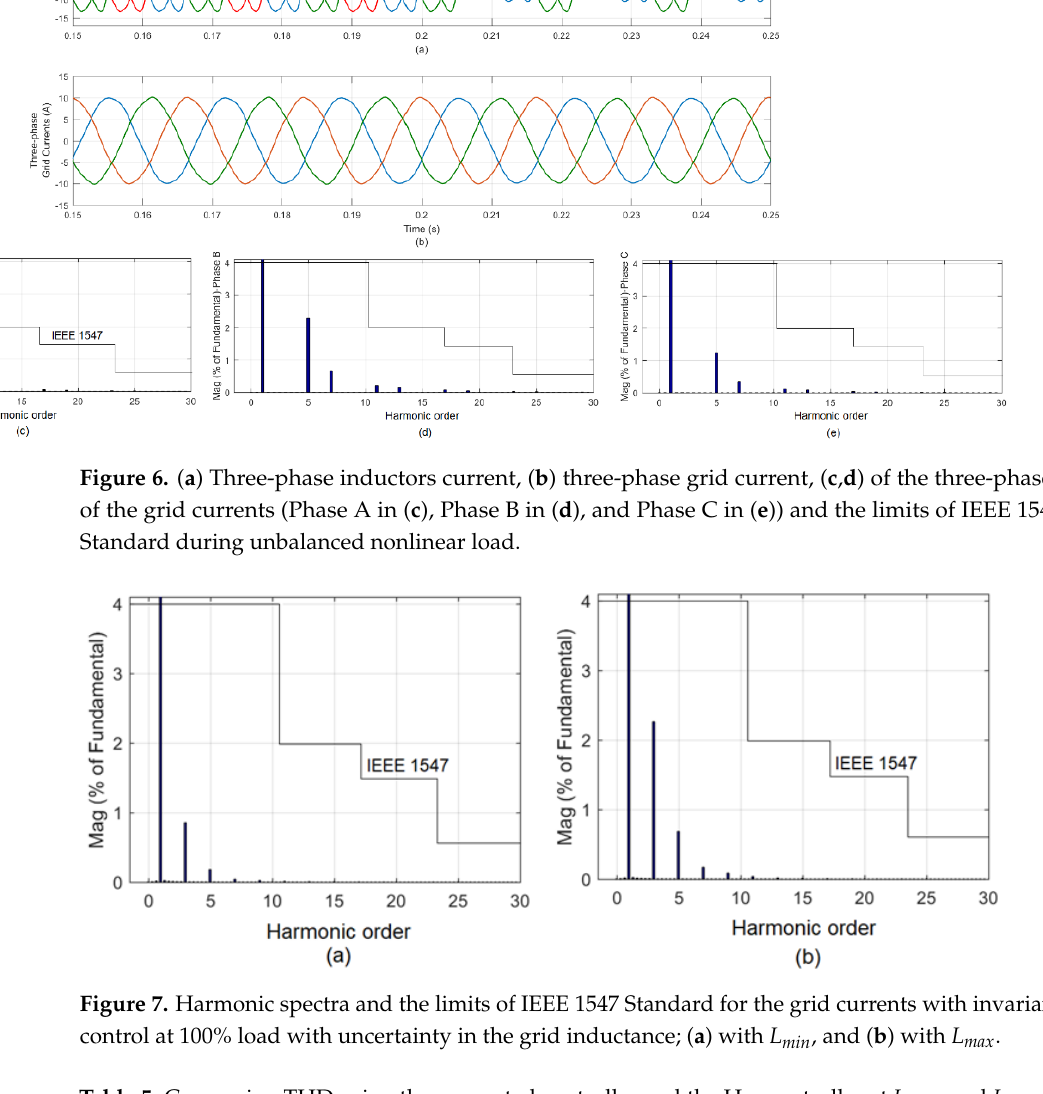
Figure 6. ( a ) Three-phase inductors current, ( b ) three-phase grid current, ( c , d ) of the three-phases of the grid currents (Phase A in ( c ), Phase B in ( d ), and Phase C in ( e )) and the limits of IEEE 1547 Standard during unbalanced nonlinear load.